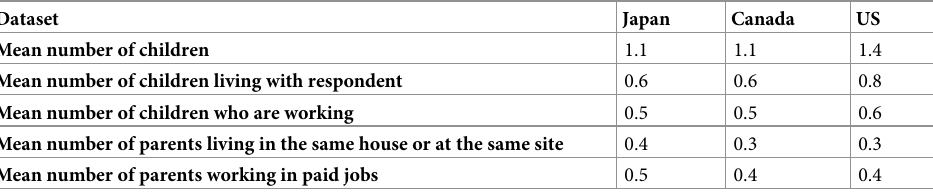
Table 2. Characteristics of respondents’ children and